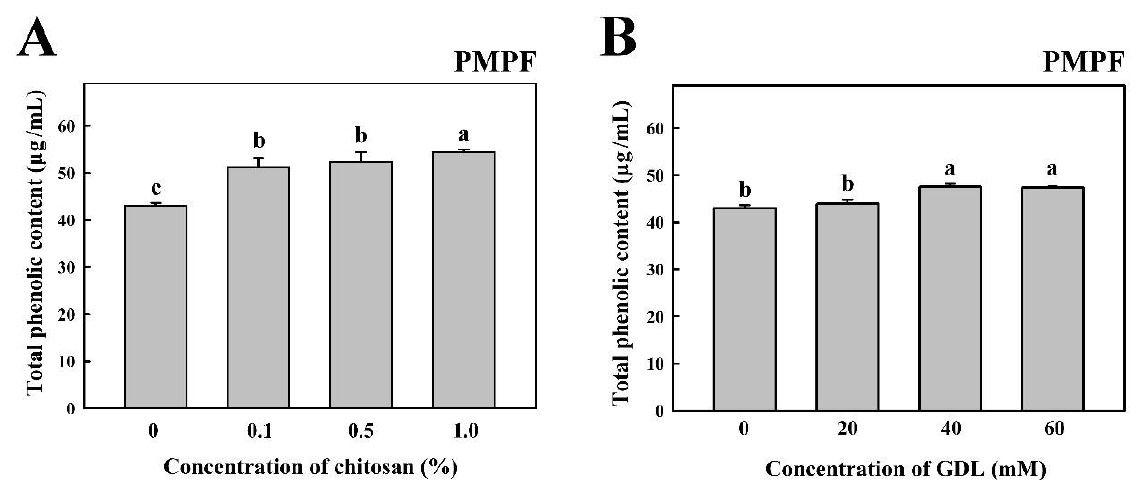
Figure 6. Effects of chitosan (0, 0.1, 0.5, and 1.0%) or GDL (0, 20, 40, and 60 mM) on the TPC in pea milk pellet fraction (PMPF). ( A ): chitosan. ( B ): GDL. Different letters indicate significant differences ( p < 0.05).